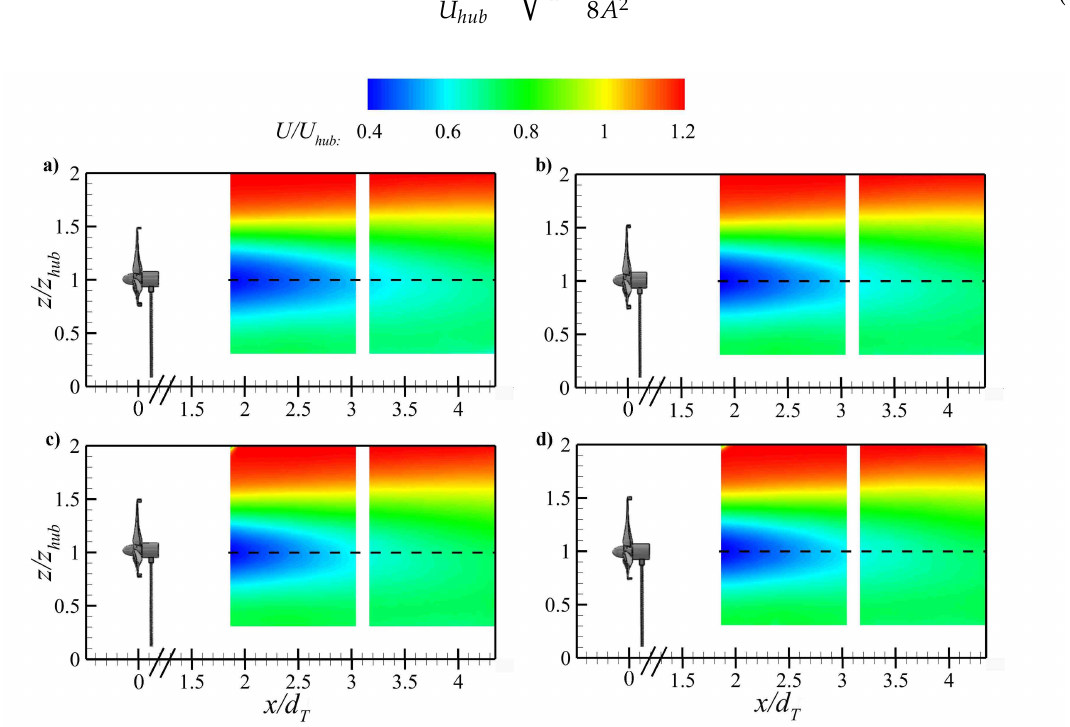
Figure 6. Normalized mean streamwise velocity distribution, U / U hub , in the central plane for the turbines with winglet pitch angle under α = ( a ) 0 ○ , ( b ) 30 ○ , ( c ) 60 ○ , and ( d ) 90 ○ .